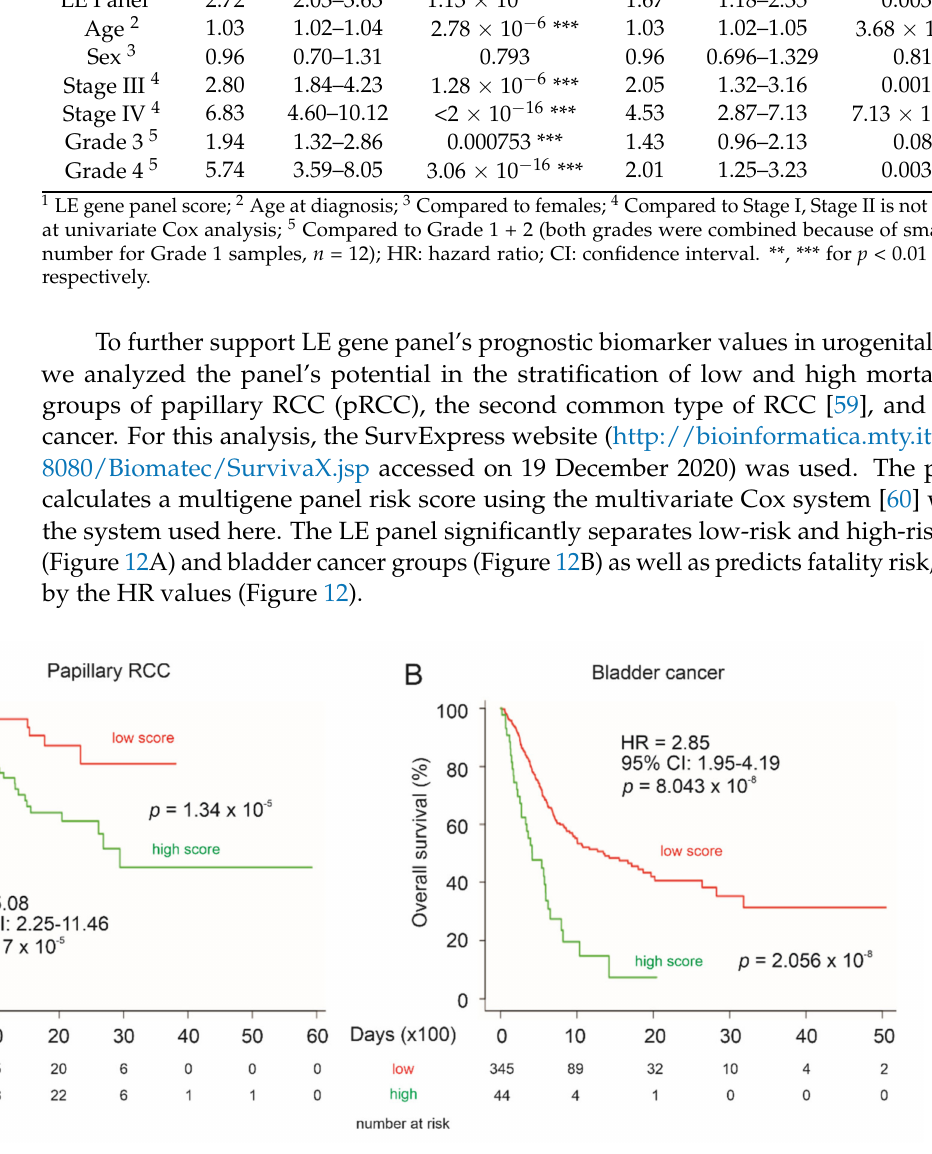
Figure 12. Prediction of poor OS of pRCC and bladder cancer using the LE multigene panel. Kaplan–Meier survival curves of pRCC ( A ) and bladder cancer ( B ). The TCGA pRCC ( n = 278) and bladder cancer ( n = 390) datasets were organized by SurvExpress. Risk scores of LE panel were calculated using multivariate Cox fitting; cutoff points were optimized to stratify low-risk and high-risk